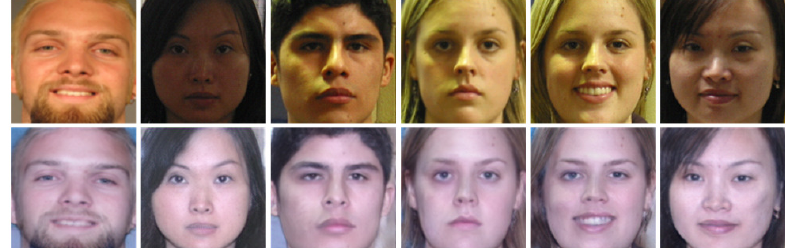
Figure 11. Some poor-lighted faces of FRGC dataset before and after processing by our algorithm. The first row is original facial images under various illumination conditions. The second row is the illumination-processing results of our